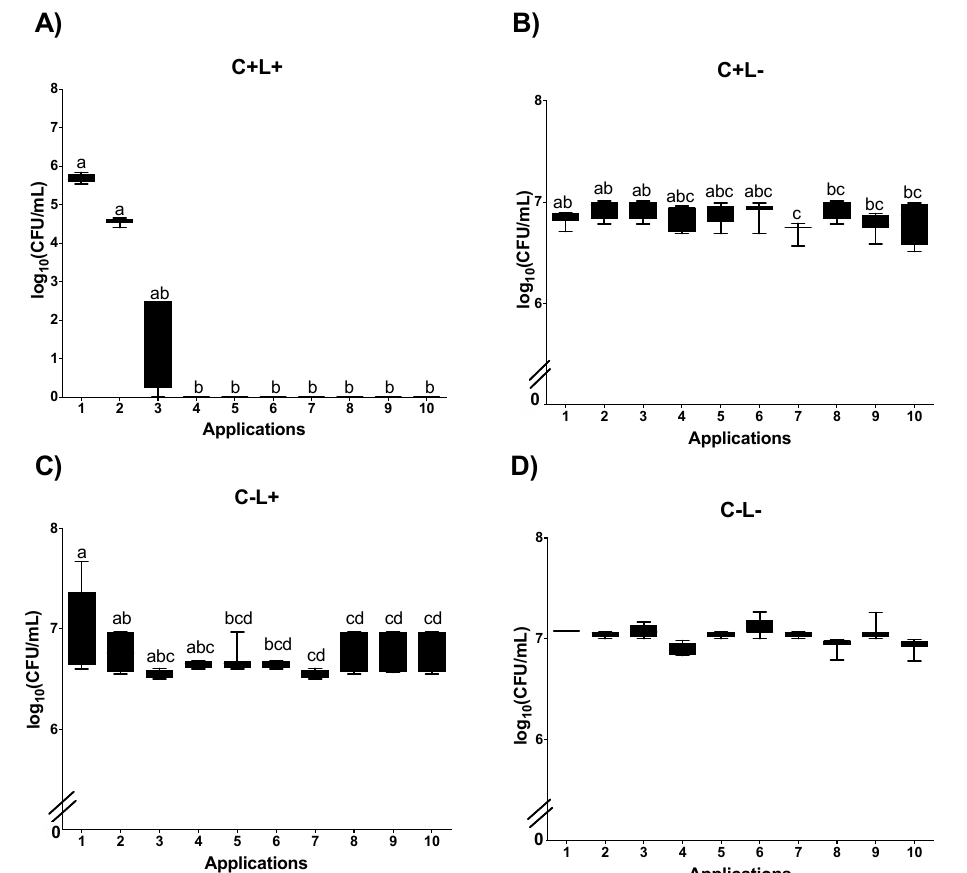
Figure 4. Log 10 values (CFU/mL) of planktonic cultures of C. albicans submitted to ( A ) CUR (C+L+), ( B ) CUR (C+L − ), ( C ) light (C − L+), and ( D ) experiment control (C − L − ). Upper limit of the box: third quartile; lower limit of the box: first quartile; error bars: minimum and maximum values. Different letters (a; b; c; d) denote a statistical difference between columns (applications) according to Dunn’s post-test ( p < 0.05) ( n = 12).